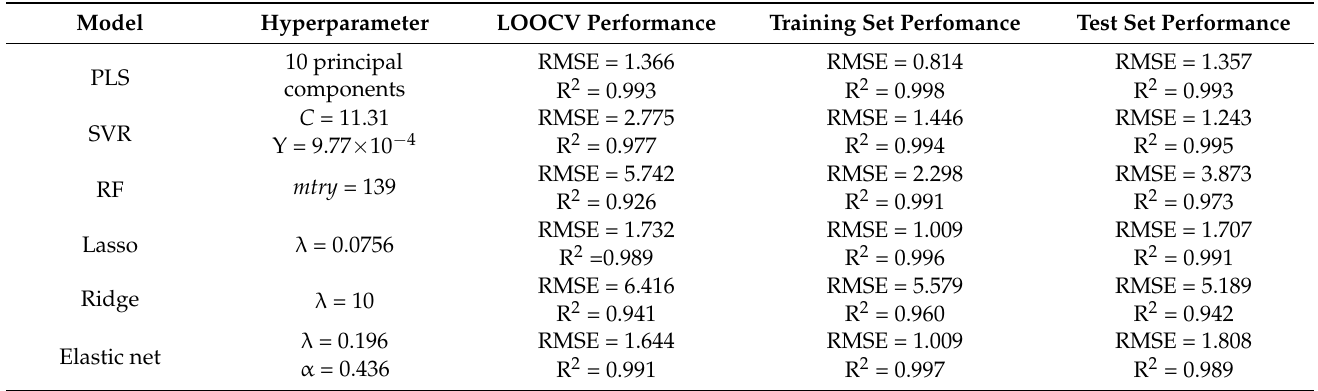
Table 3. Results obtained for each regression method applied in the quantification of the